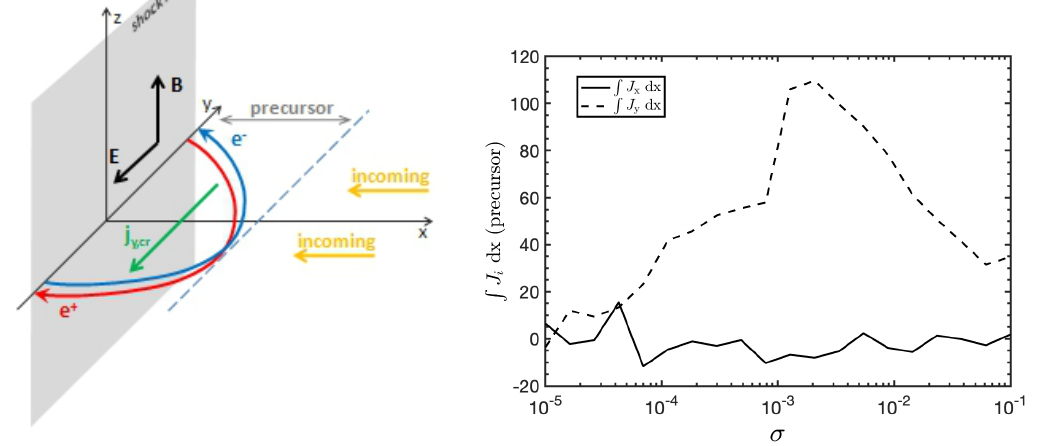
Figure 6. Left panel: Sketch of the development of the perpendicular current driven instability at a moderately magnetized relativistic collisionless shock. Here, the shock propagates toward along the x -direction and the external magnetic field lies in z -direction. In the shock rest frame, this magnetic field is accompanied by a motional electric field along − y . The suprathermal particles gyrate in this electromagnetic structure in the course of their upstream Fermi cycles, generating a net perpendicular electrical current j b , oriented along E . As the background plasma enters the precursor, it seeks to compensate this perpendicular current, which triggers the PCI. Right panel: Measurement of the global x and y electrical, as integrated over the length scale of the precursor, as a function of the external magnetization σ , taken from PIC simulations reported in [111]. At 10 − 4 (cid:46) σ (cid:46) 10 − 2 , a net perpendicular current is